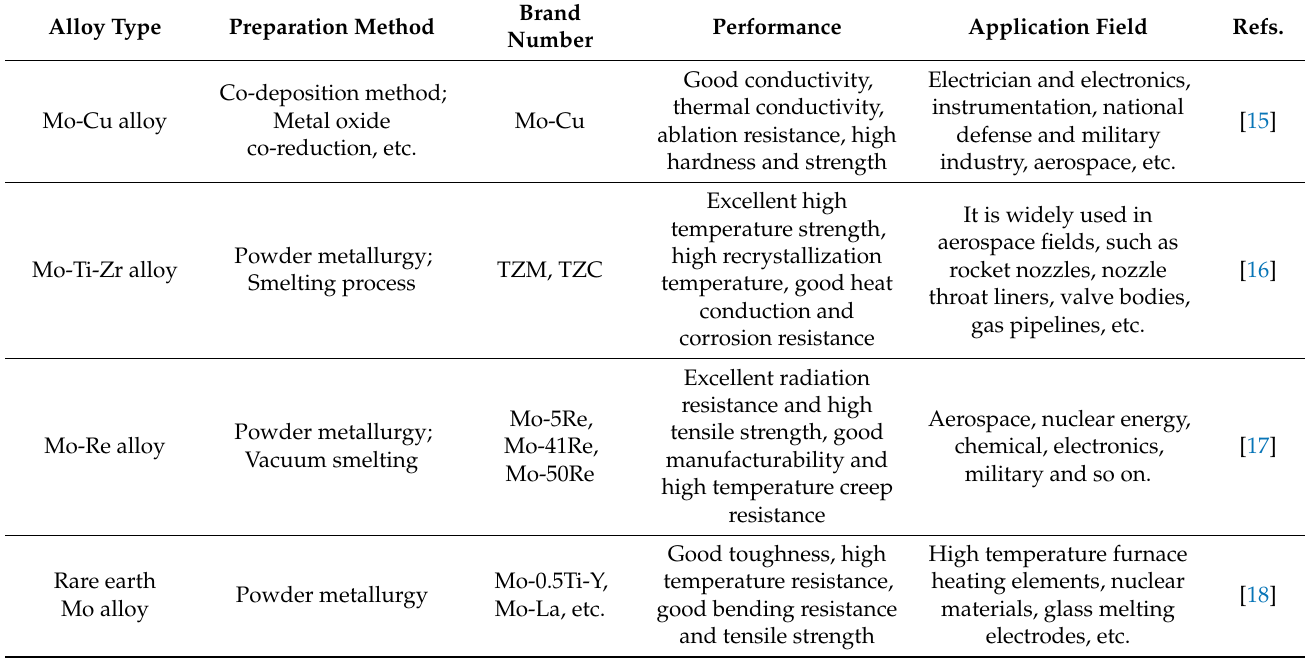
Table 1. Classification and application of Mo-based alloys.